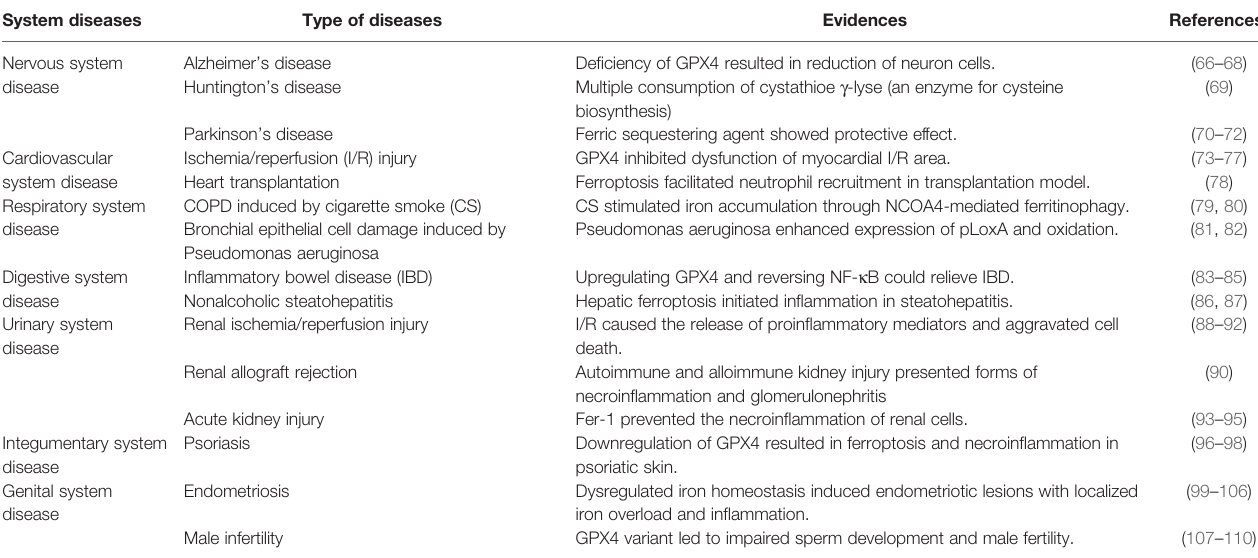
TABLE 3 | Ferroptotic tissues and organs presenting necroin fl